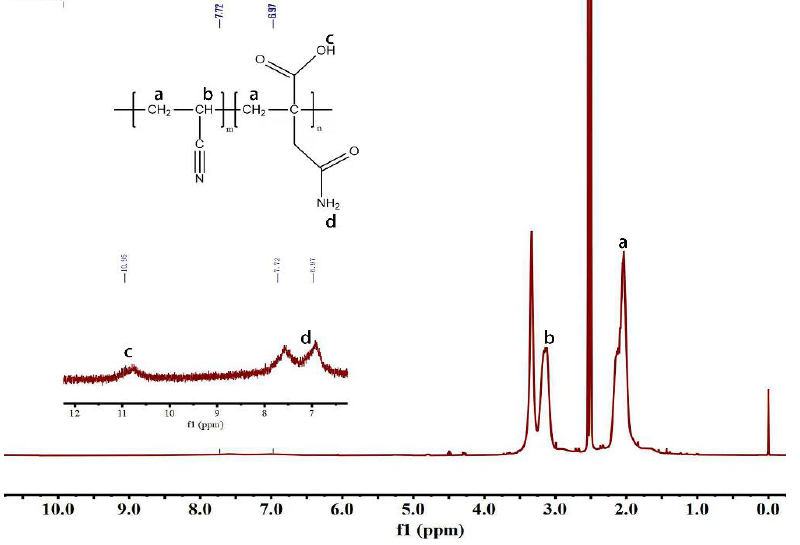
Figure 4. 1 H NHR spectra of P (AN-co-MLA) copolymer with AN/MLA = 95/5 (wt/wt).